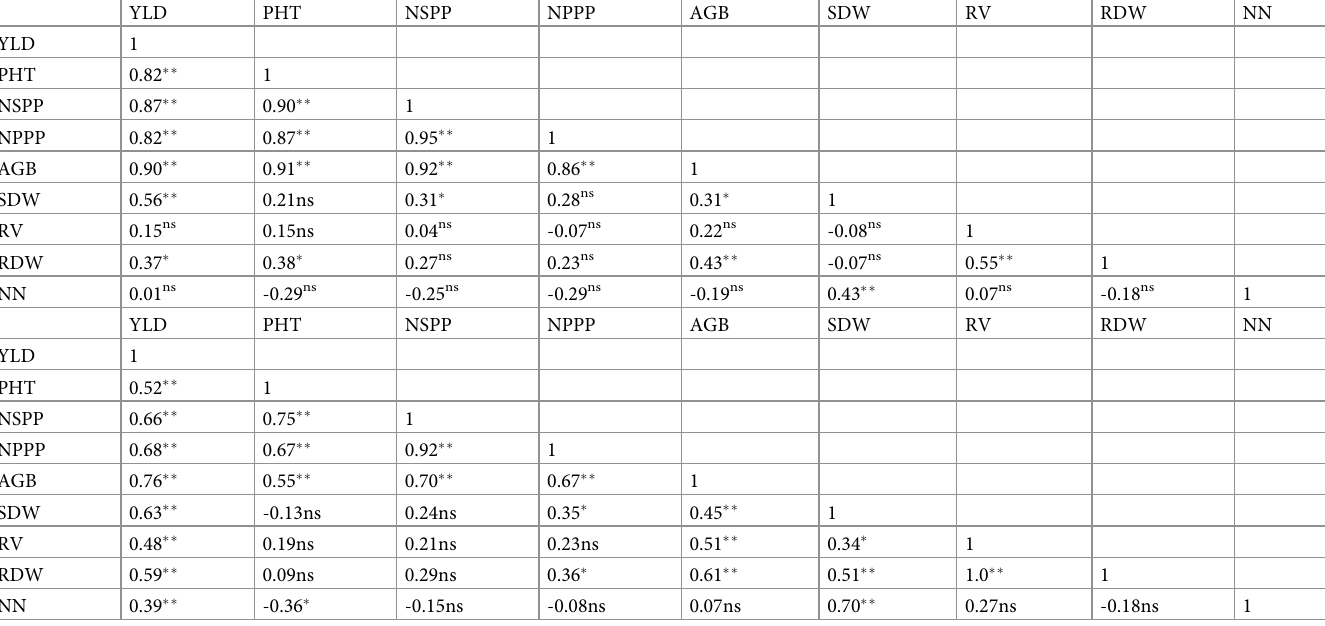
Table 11. Pearson correlation analysis for growth, root, nodulation, yield and yield components of soybean genotypes grown under lime treated (1st) and lime untreated (2nd) soil on field at Mettu.